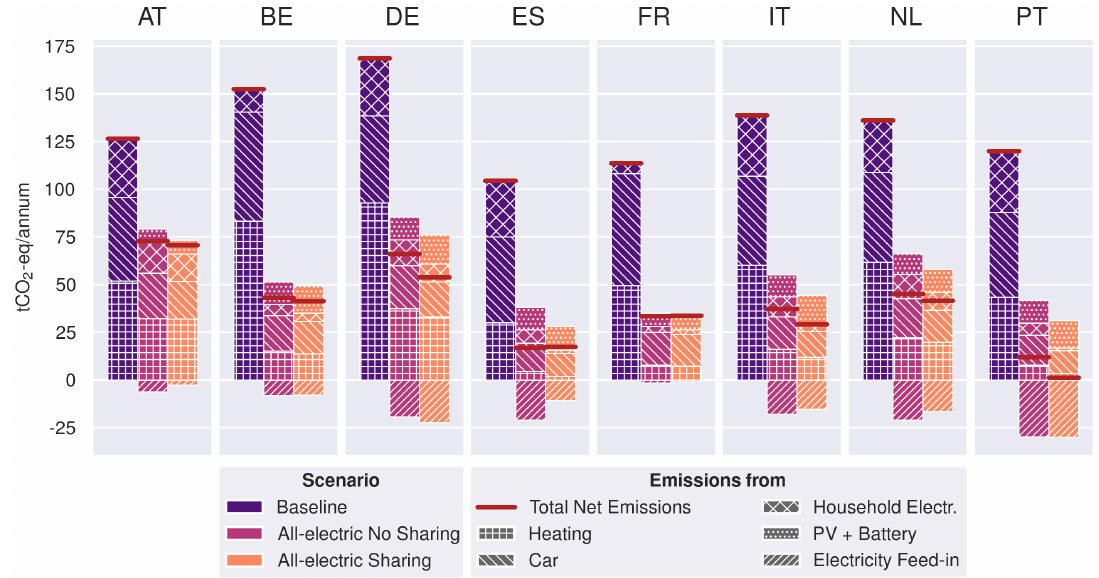
Figure 5. Overview of total annual greenhouse gas emissions of the whole community. Results are shown for all countries, for the baseline and two all-electric